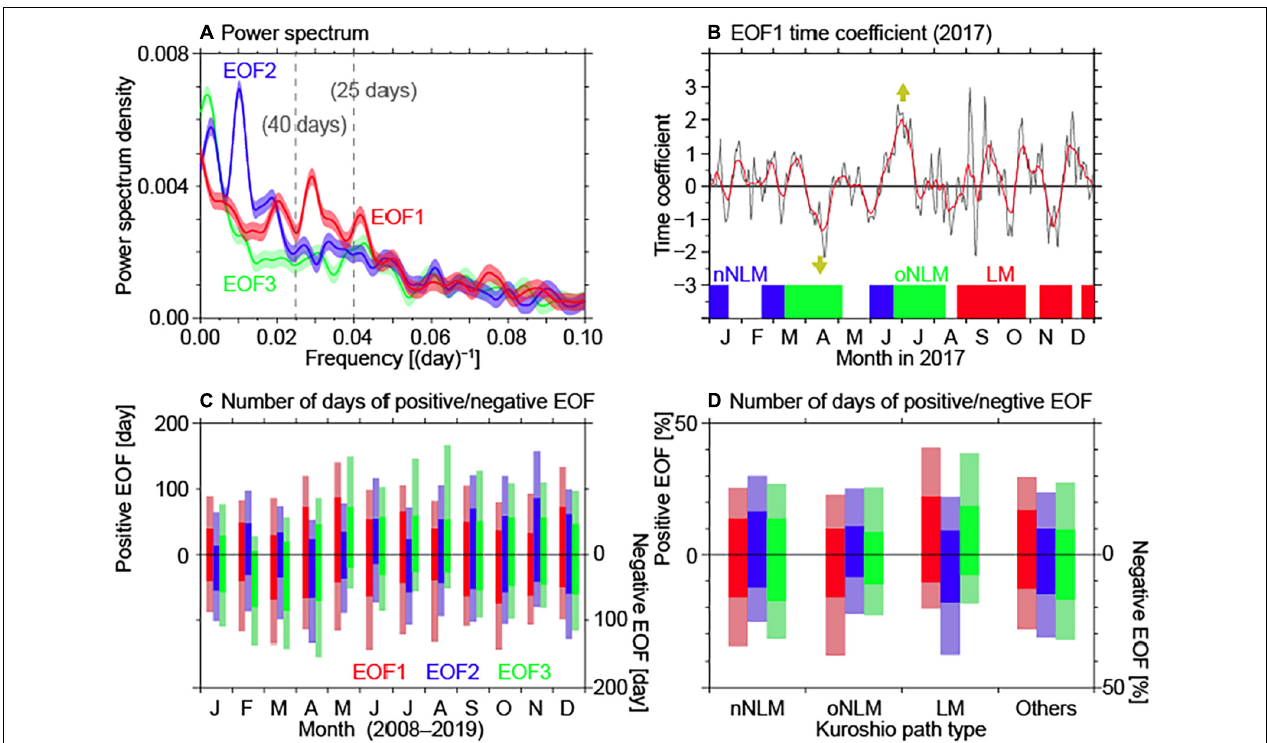
FIGURE 4 | (A) Power spectra for daily time coefficients of the EOF modes (red, blue, and green for EOF1, EOF2, and EOF3, respectively) based on the fast Fourier transform method. A Tukey filter with the effective width of 0.005 [frequency in (day) - 1 ] was applied. Shading denotes the 1% significance level. (B) Daily and smoothed (11-day running mean) time series of the time coefficients of EOF1 for 2017 (black and red line, respectively). The Kuroshio path types are indicated by color bars as in Figure 2B . (C) Total number of days when the EOF time coefficient (red, blue, and green for EOF1, EOF2, and EOF3, respectively) is greater than +1 (left axis; upper half) and smaller than − 1 (right axis; lower half) for each month during the period 2008–2019 (thick colors). Thin colors indicate the same but using a threshold of ± 0.5. (D) Same as (C) but for each type of the Kuroshio path and units are in % of the total days for each